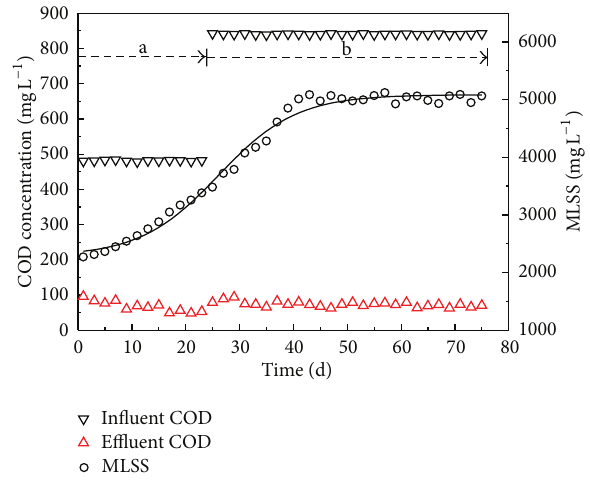
Figure 2: Concentration variation of COD and MLSS in startup and steady run